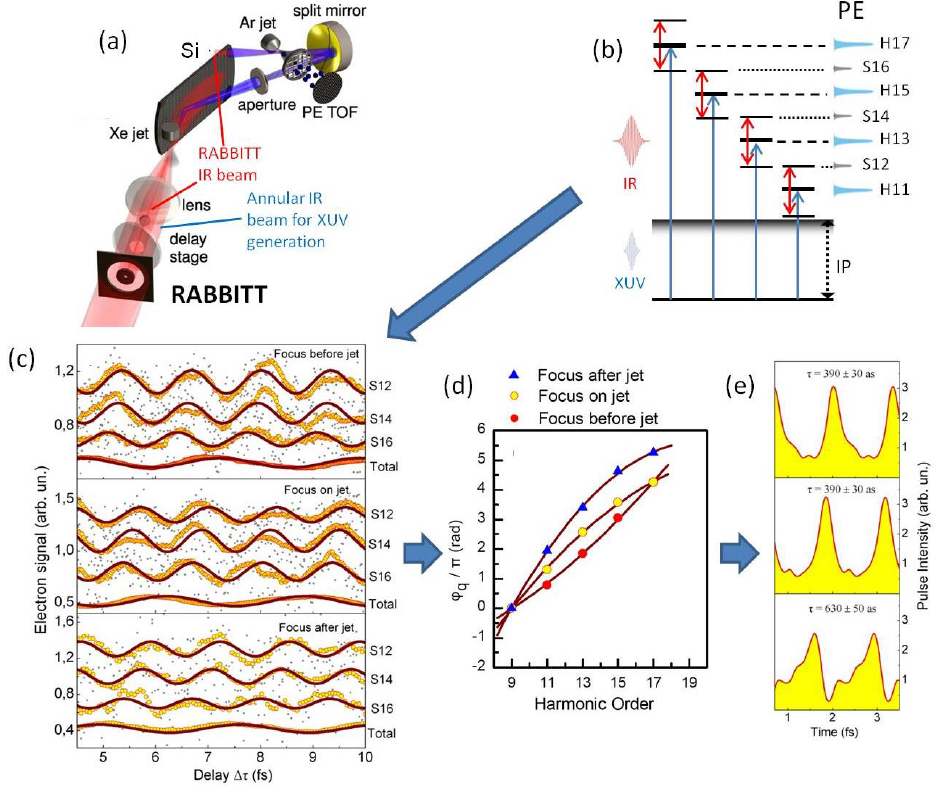
Figure 11. ( a ) Experimental set-up showing the Resolution of Attosecond Beating by Interference of Two photon Transitions (RABBITT) arrangement. It is a 3D illustration of a part of the beam line shown in Figure 8; ( b ) XUV + IR ionization scheme; ( c ) RABBITT traces at three different positions of the laser focus with respect to the Xenon gas jet (focus before jet, focus on jet and focus after jet). The gray dots are the measured data, the yellow circles correspond to a running average of 15 points and 40 points for the total signal. The solid purple lines are sinusoidal fits to the raw data over 13 oscillations on the sideband traces and over 6 oscillations on the total signal; ( d ) Phases of the consecutive harmonics obtained by the RABBITT traces; ( e ) Reconstructed asec pulse trains. Figures ( a , c – e ) from Ref. [97].